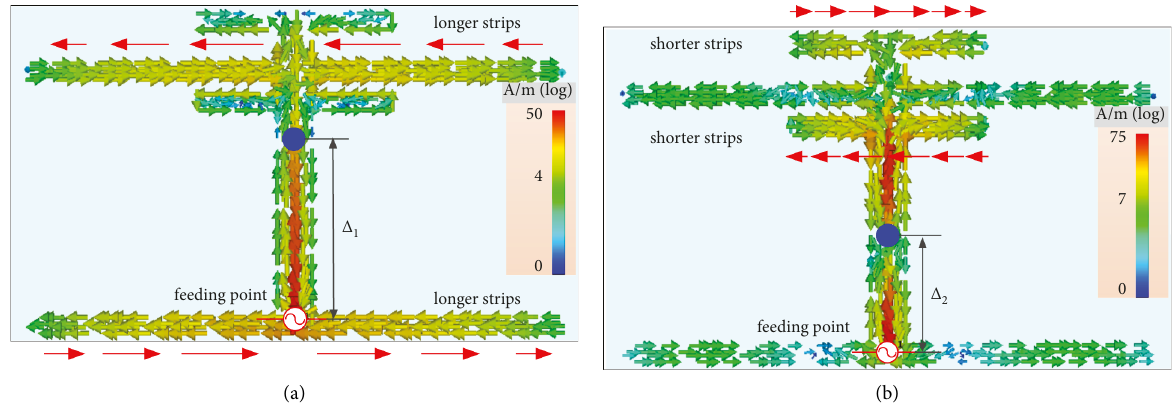
Figure 5: Current distribution of the proposed antenna at 2.4/5.8 GHz (a) at 2.4GHz(b) at 2.4GHz. dB